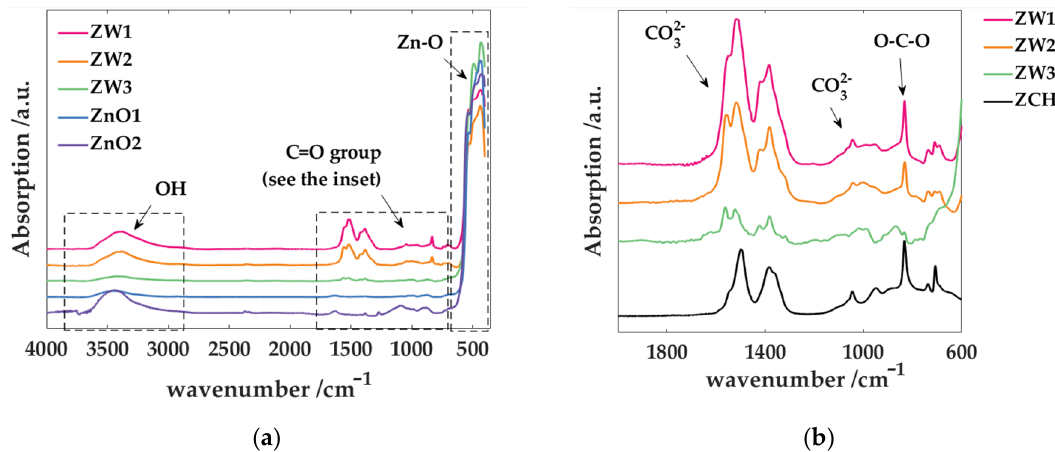
Figure 1. ( a ) Infrared vibrational spectrum of the five samples in the 450 to 4000 cm − 1 wavenumber region. ( b ) A detail of the 600–1800 cm − 1 band, where the zinc white samples are characterised by the typical infrared pattern of zinc carbonate hydroxide shown and labelled as ZCH (analytical grade, ACROS Organic).